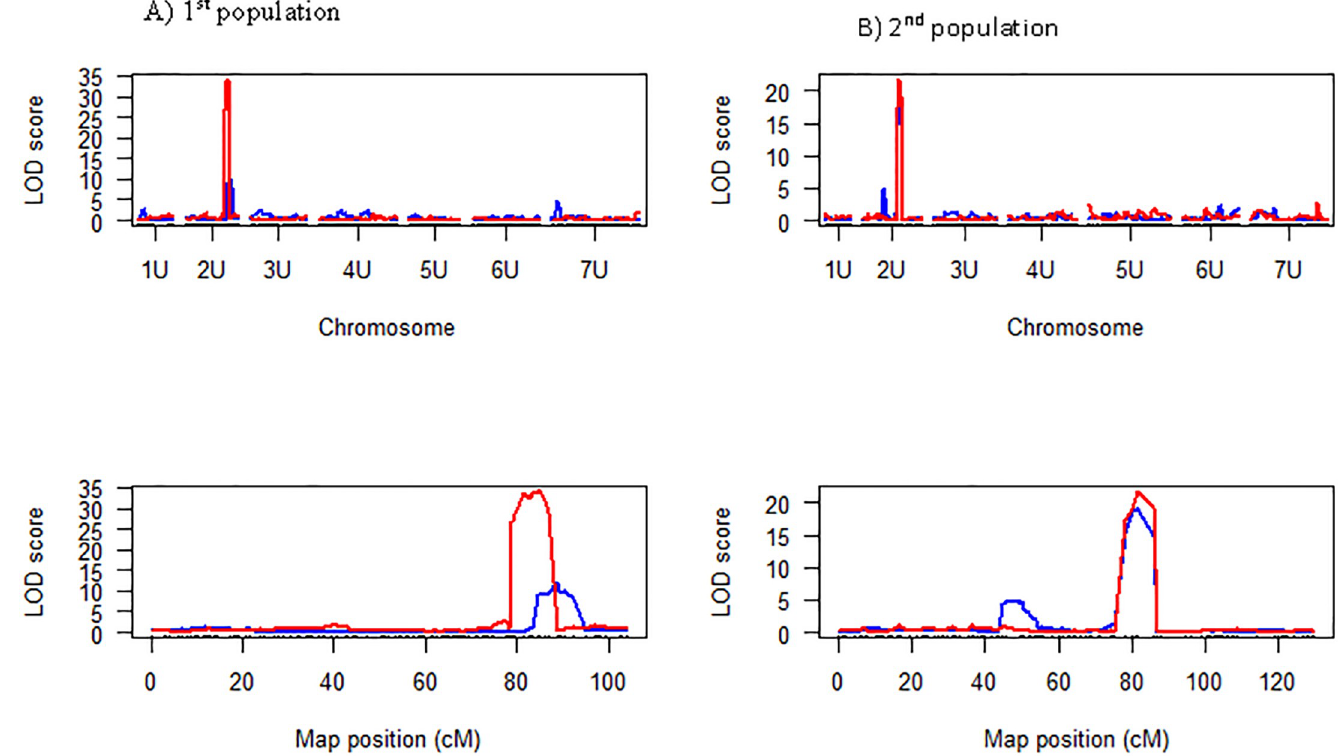
Fig 1. Chromosome and logarithm of odds (LOD) profile of stem resistance QTL detected for races TTTTF and TTKSK in two the Ae . umbellulata F 2:3 populations. A) 1 st population. B) 2 nd population.